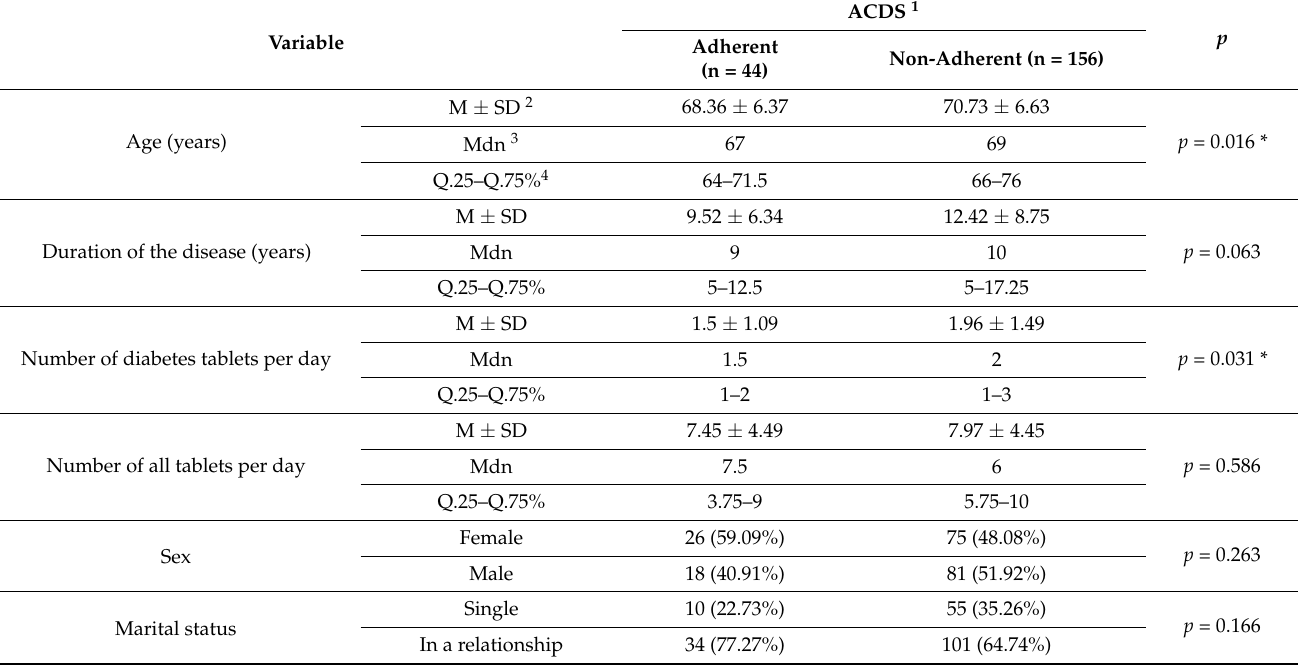
Table 6. Adherent and non-adherent patients—univariate